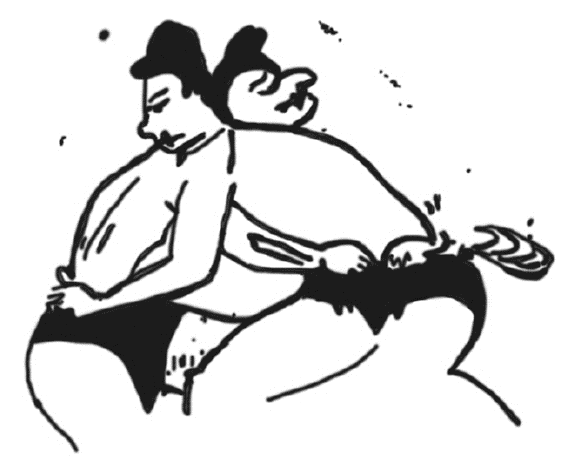
Figure 25. Part of a mural painting discovered in Ji’An, Jilin. Third to fourth century, CE. Li (1983), p. 8.